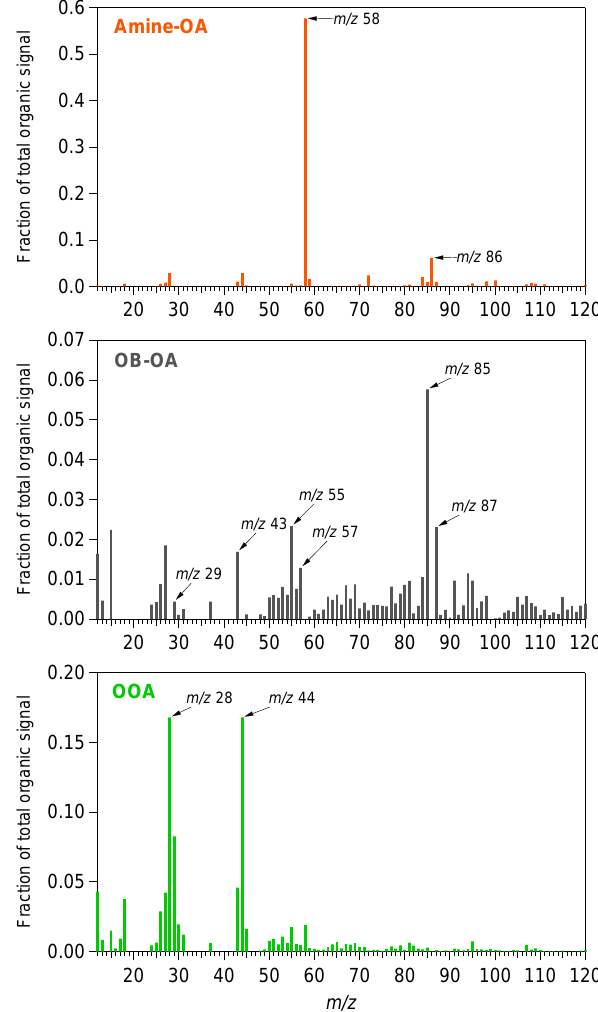
Fig. 6. Mass spectra of OA components from the 3-factor PMF solution. The signals at m/z 28 and m/z 44 are equal by definition in the organic fragmentation